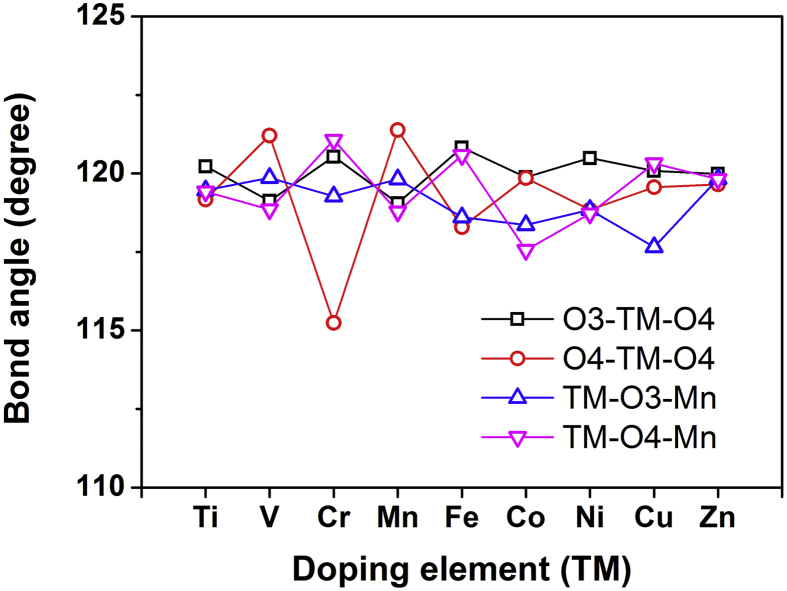
Main bond angles for TMO5 bipyramids in hexagonal YMn0.917TM0.083O3 bulks dependence on doping elements (TM) from Ti to Zn.